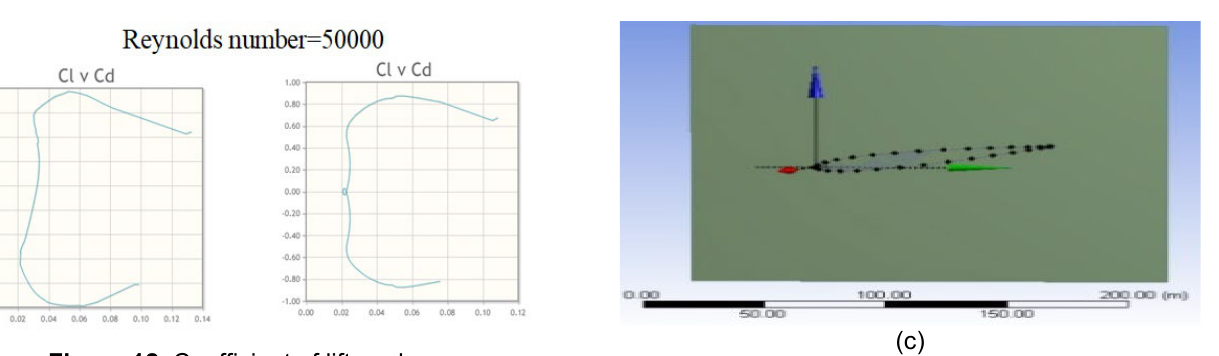
Figure 12. Coefficient of lift vs drag